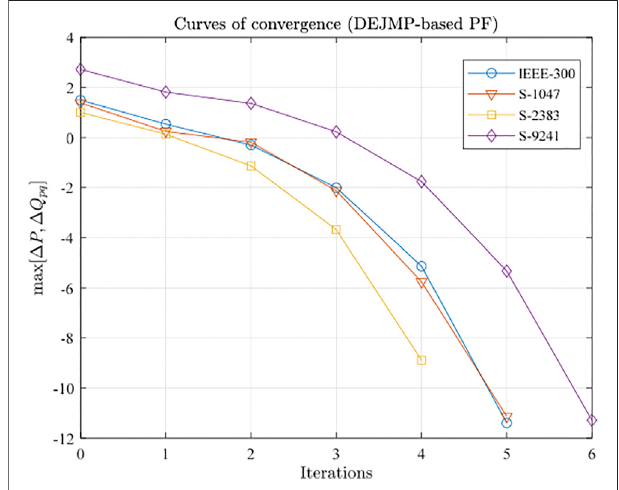
FIGURE 1 | Curves of